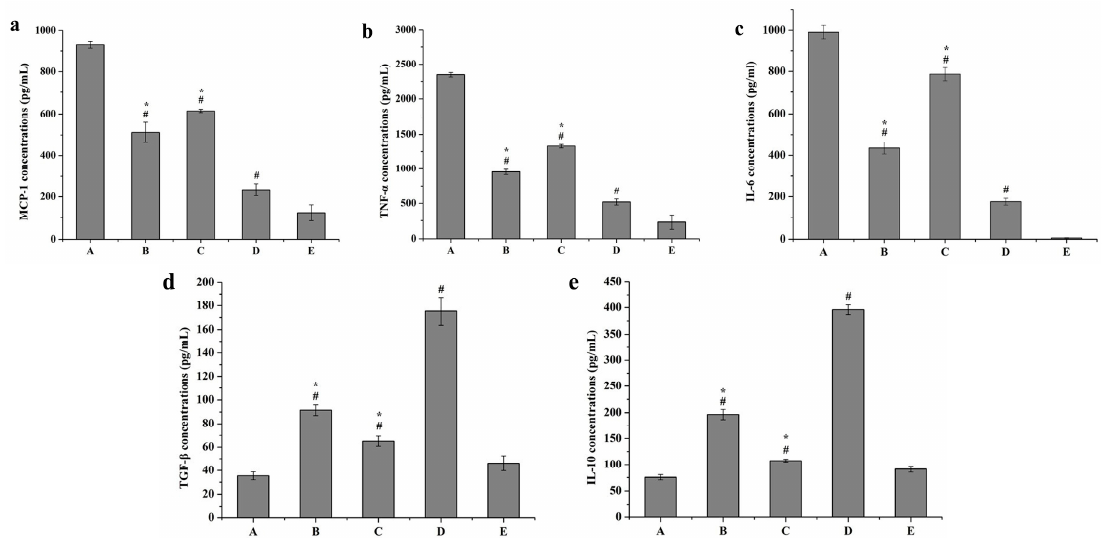
Figure 12. Protein expression levels of pro-inflammatory factors (MCP-1, TNF- α , IL-6) and anti-inflammatory factors (TGF- β and IL-10). ( A ) positive control group; ( B ) curcumin solutions; ( C ) blank PS-containing carriers; ( D ) Cur-mNLCs; ( E ) negative control group; # p < 0.01, compared with A, * p < 0.01, compared with D; (a) ELISA assay for expression of MCP-1, (b) ELISA assay for expression of TNF- α , (c) ELISA assay for expression of IL-6, (d) ELISA assay for expression of TGF- β and (e) ELISA assay for expression of IL-10 (mean ± SD, n = 6). Protein expression levels (fold change) of all pro-inflammatory cytokines were remarkably reduced in the curcumin solutions group (B), blank PS-containing carriers group (C) and Cur-mNLCs group (D), compared with the positive control group (A) ( p < 0.01 for Group B, C, or D vs . Group A). The combination of curcumin and PS (Cur-mNLCs) exerted a more potent inhibiting effect, in comparison with curcumin or PS alone ( p < 0.01 for Group B or C vs . Group D). Curcumin solutions (Group B), blank PS-containing carriers (Group C) and Cur-mNLCs (Group D) all enhanced the protein expression levels of anti-inflammatory cytokines, compared with the positive control group ( p < 0.01 for Group B, C, or D vs . Group A). Among the three treatment groups (Groups B, C, and D), Group D displayed the most significant effects ( p < 0.01 for Group B or C vs . Group D).